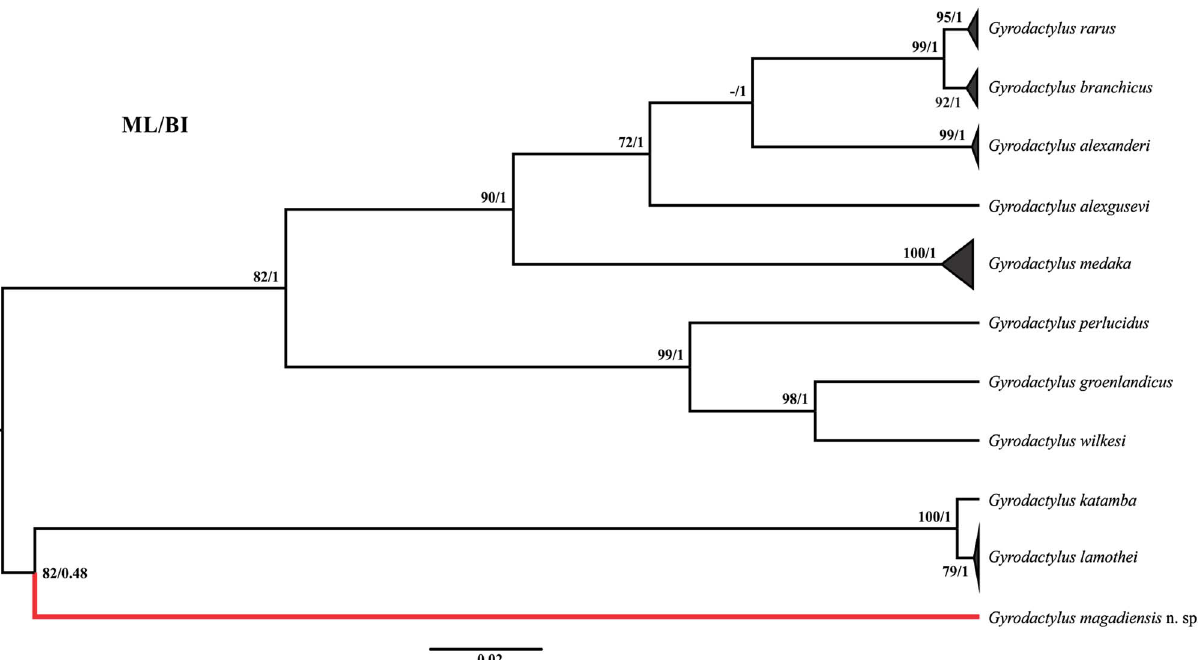
Figure 4. Evolutionary history of Gyrodactylus magadiensis n. sp. based on Bayesian Inference approaches using ITS sequences for selected gyrodactylids. Statistical support for Bayesian inference (BI) and maximum likelihood (ML) methods indicated at branch nodes with posterior probabilities and bootstrap support indicated, respectively